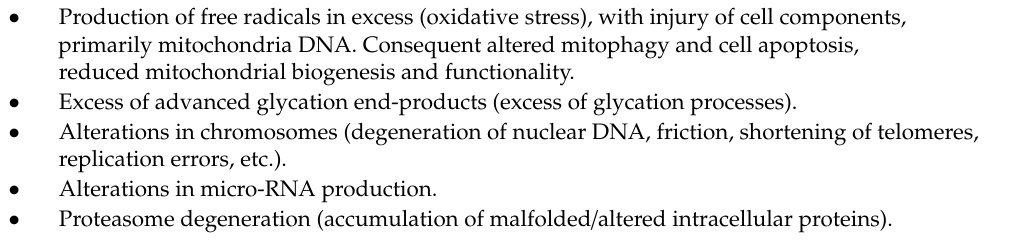
Table 1. Main biochemical processes of chronic low-grade cellular inflammation and aging.